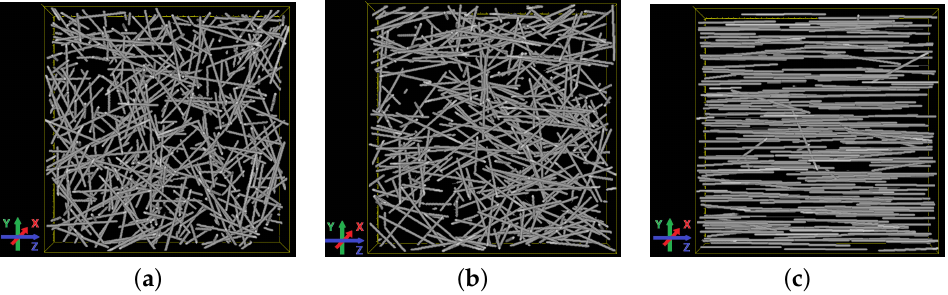
Figure 5. Realisations of the fibre model for different anisotropy parameters β . ( a ) β = 1 (isotropic); ( b ) β = 0.5; ( c ) β =